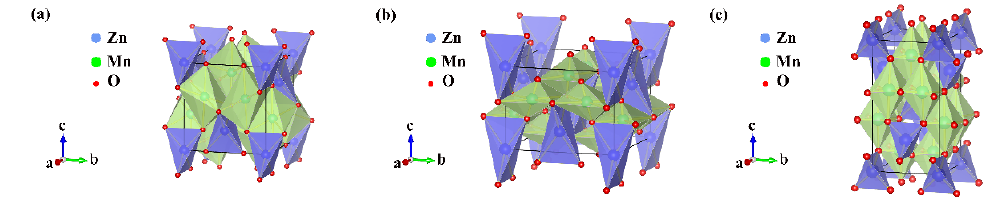
Figure 2. Schematic crystal structure of ZnMn 2 O 4 spinel produced for ( a ) 6 h, ( b ) 12 h, and ( c ) 18 h.